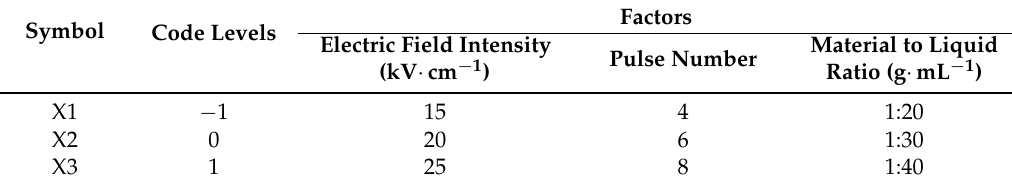
Table 6. Coding table and selected values (obtained from previous studies) for experimental factors and levels in response surface method (RSM) for pulsed electric field (PEF)